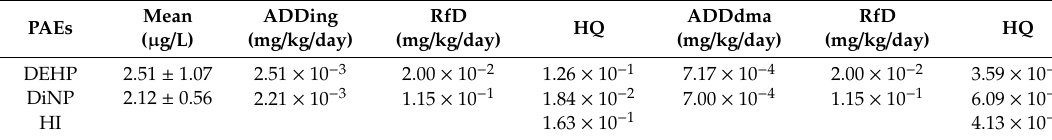
Table 5. HQ values of exposure to PAEs via ingestion and dermal contact in children.